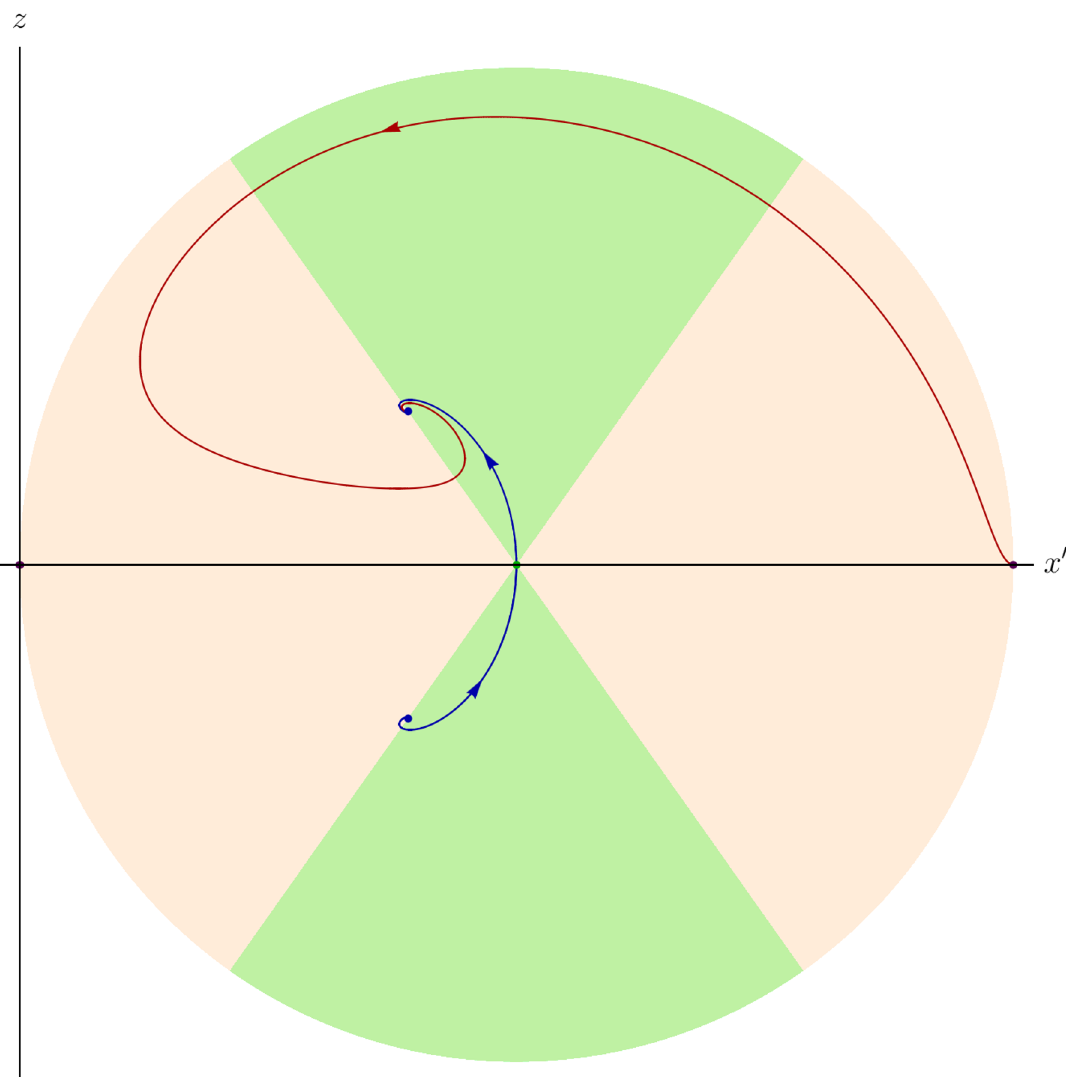
Figure 6 . Two trajectories lying on the invariant plane P of the dynamical system obtained from the compactification with m, k 6 = 0 . The point p corresponding to a Milne universe is depicted in 0 green. The point p (and its mirror in the southern hemisphere) is drawn in blue and corresponds 1 to a Milne universe with angular defect. The equator fixed points coincide with a scaling cosmology with S ∼ T 1 and are illustrated in purple. The red trajectory enters and exits the acceleration region 3 an infinite number of times, spiraling around p , see figure 5 for a zoom around this region. Depicted 1 in blue is the unique (fine-tuned) trajectory: the solution becomes de Sitter in the vicinity of the origin, which is reached at finite proper time. The solution can be geodesically completed in the past beyond the point at the origin, by gluing together its mirror trajectory in the southern